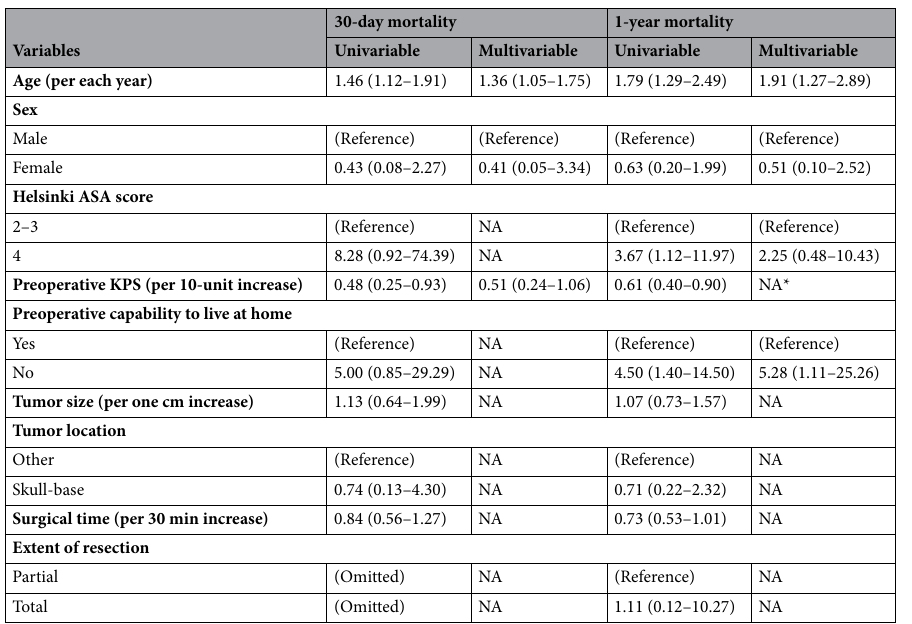
Table 2. Odds ratios (ORs) with 95% confidence intervals (95% CIs) for short-term (30-day) and 1-year mortalities. Multivariable model includes significant factors from univariable model and patients’ sex. ASA American Society of Anesthesiologist; KPS Karnofsky performance status; NA not applicable. *Due to strong correlation between preoperative KPS and preoperative independence, we excluded preoperative KPS from the multivariable model for 1-year